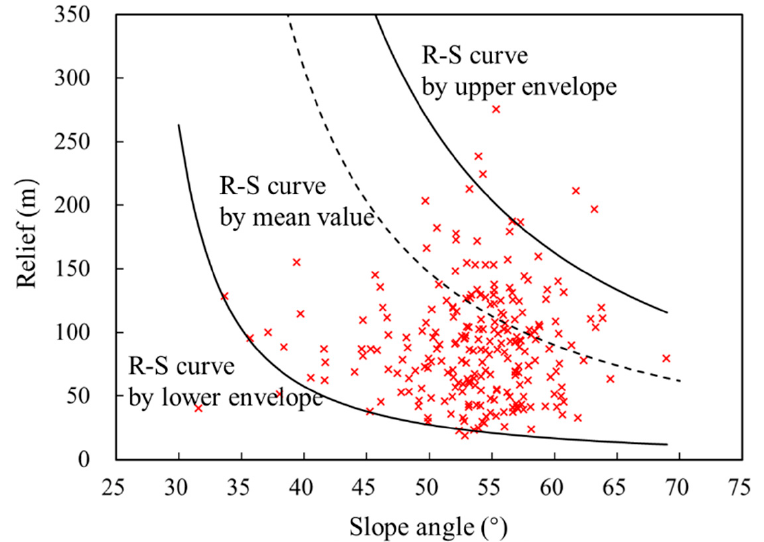
Figure 5. Rock mass strength fitting result and the relief–slope (R–S) angle relationship in the study area.